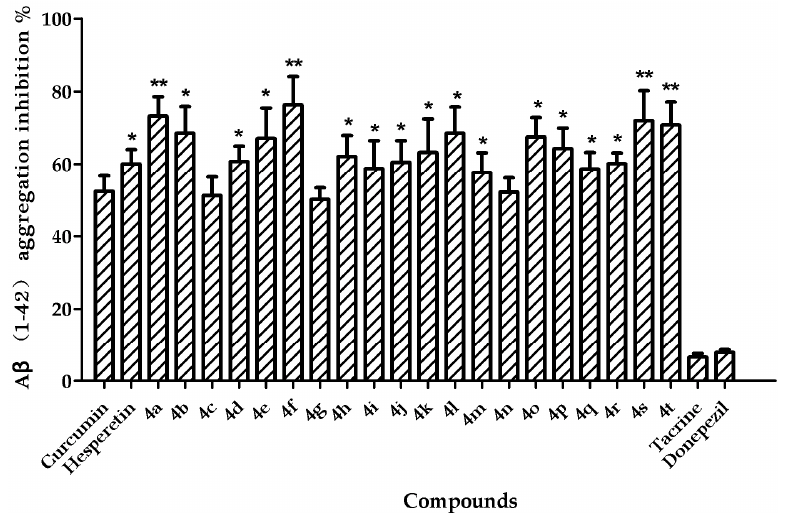
Figure 3. Effects of the compounds on A β (1–42) peptide aggregation inhibition. The compounds were used at a concentration of 20 μ M. (* P < 0.05 and ** P < 0.01 vs. curcumin group). used at a concentration of 20 µ M. (* P < 0.05 and ** P < 0.01 vs. curcumin